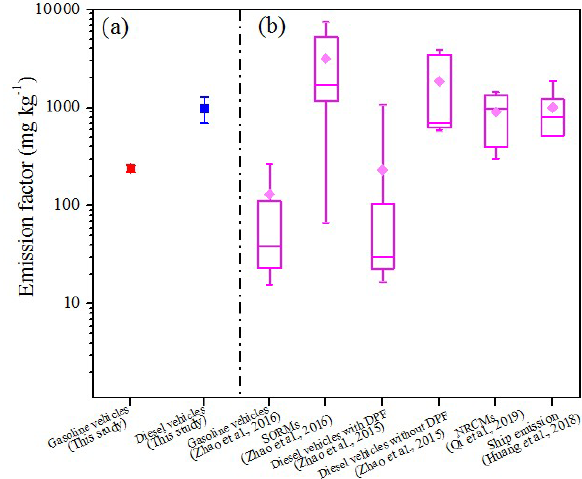
Figure 2. Comparison of the EF IVOCs measured in this study with that previously measured for fossil fuel combustion sources. The er- ror bars in (a) represent 95% confidence interval. In (b) , the boxes represent the 75th and 25th percentiles, the centerlines are the me- dians, and squares are the averages. The whiskers represent the 10th and 90th percentiles. SORMs refer to small off-road machines fu- eled with gasoline. NRCMs represent non-road construction ma- chines fueled with